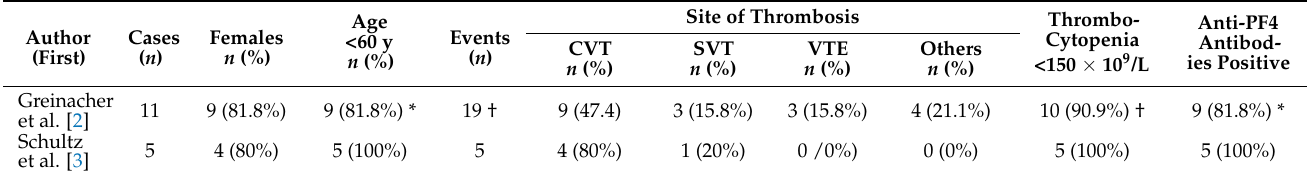
Table 1. Overview of vaccine-induced thrombotic-thrombocytopenia (VITT)